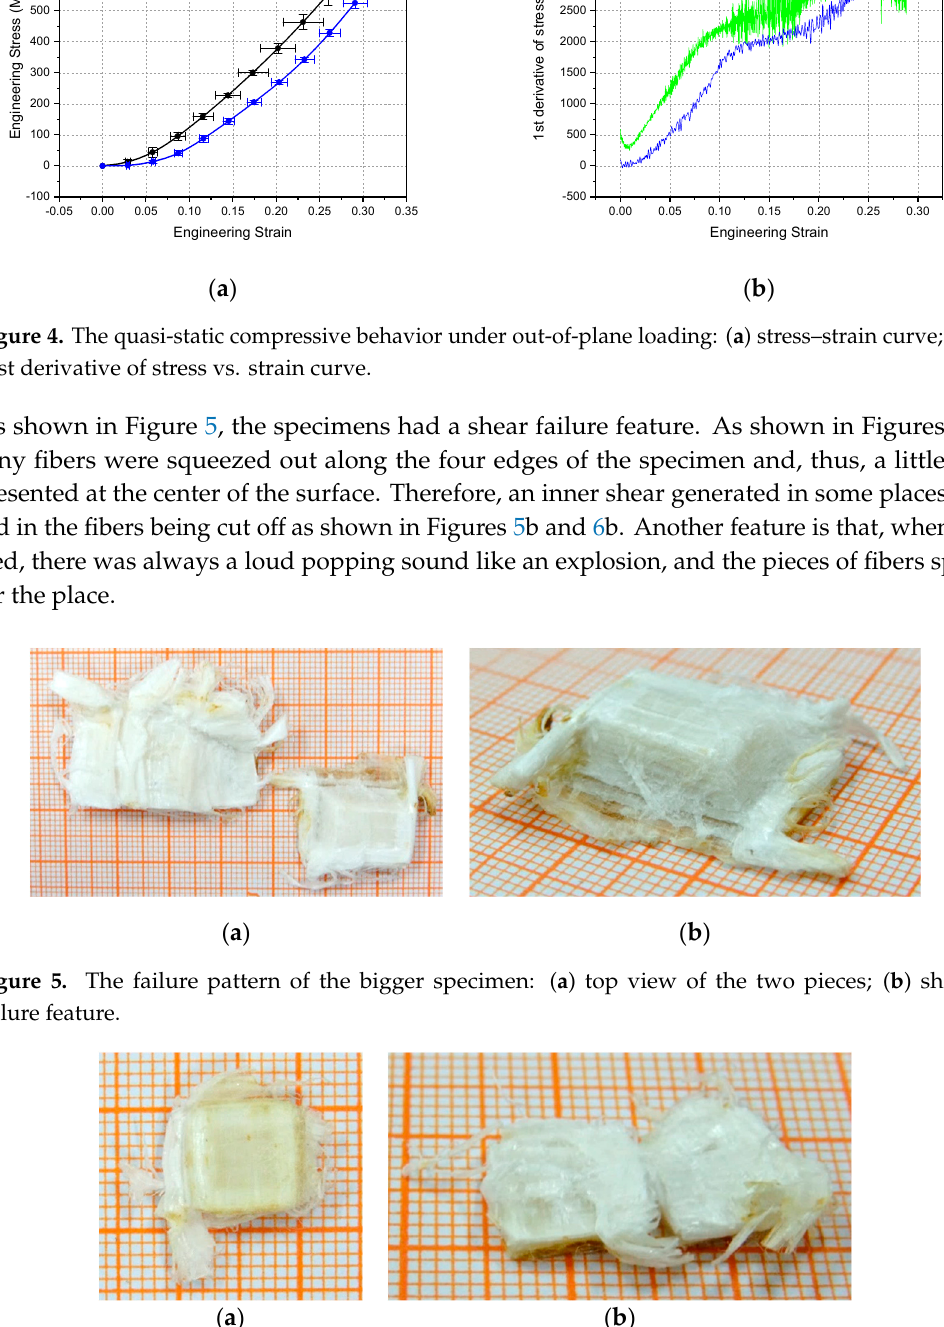
Figure 6. The failure pattern of the smaller specimen: ( a ) top view of the specimen; ( b ) inner feature of the specimen.